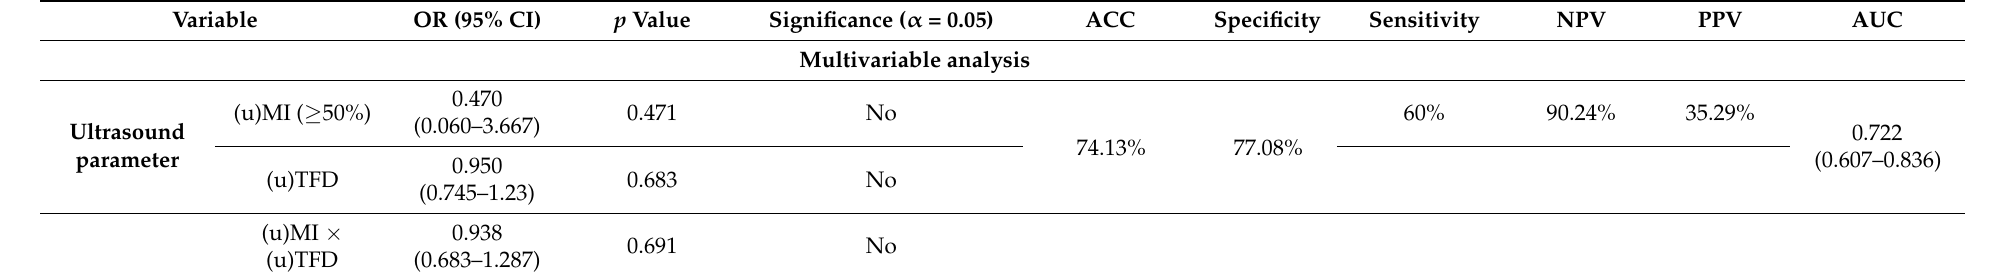
Table 3. Multivariable analysis of the value of ultrasound predictive factors for lymph node